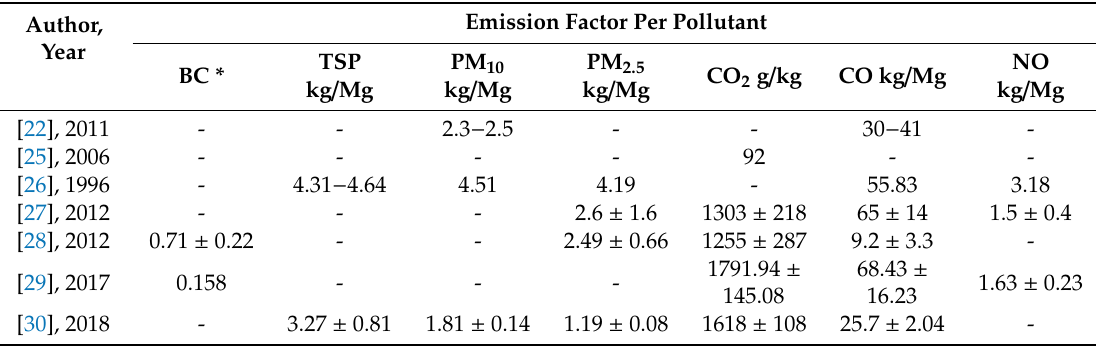
Table 3. Sugarcane emission factors reported by several authors expressed as kg of pollutant emitted per Mg of sugarcane biomass burned. Highlighted boxes indicate the values used in this work.